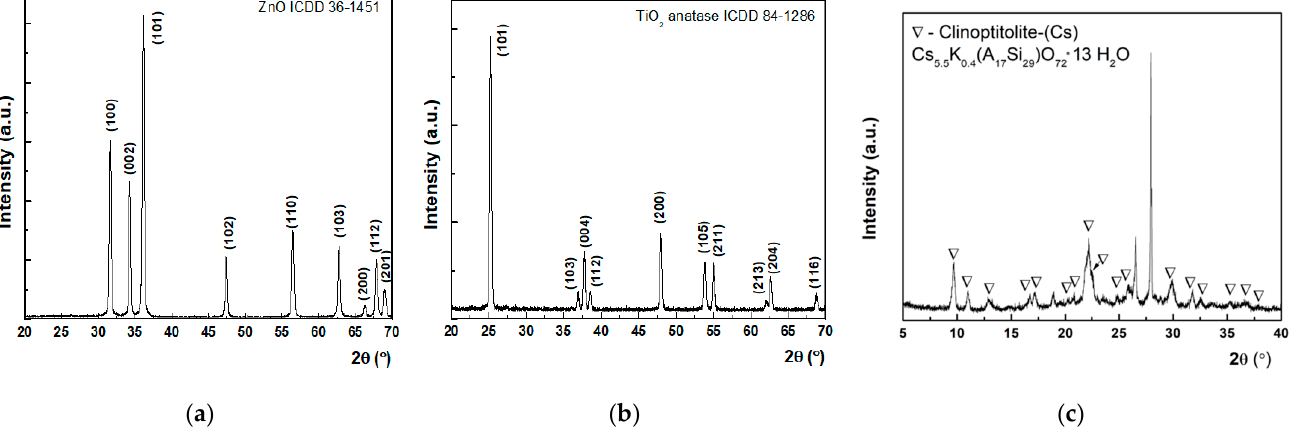
Figure 3. SEM and EDX mapping of nanoparticle clusters: ( a , b ) ZnO, ( c , d ) TiO 2 , and ( e , f ) zeolite. XRD patterns of the synthesized nanoparticles are depicted in Figure 4. These graphs were obtained by employing the PXRD technique (powder X-ray diffraction), which is a rapid technique that measures the diffraction pattern of crystalline material. Figure 5 presents the Raman spectra recorded for each of the synthesized nanoparti- cles, which were further employed as active components in the decontamination solu- tions. Figure 6 is comprised of the Raman spectra of the neat organic decontamination solution.